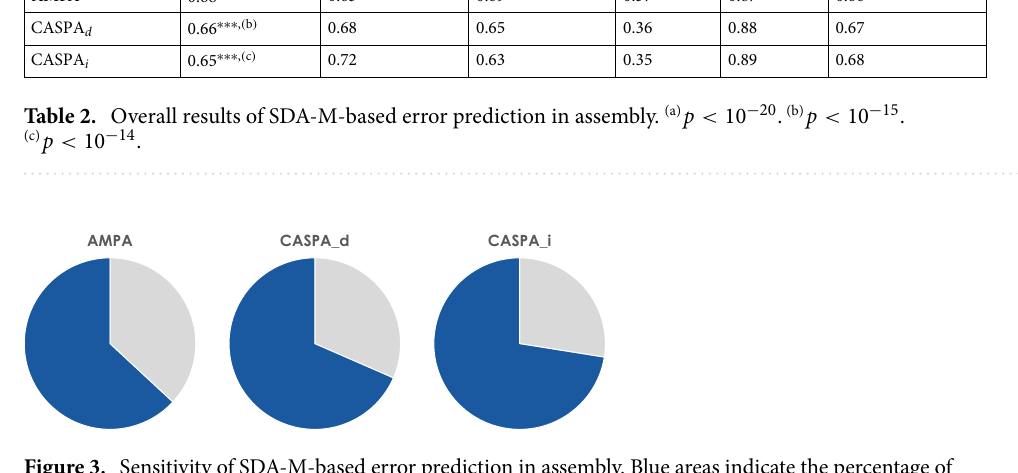
Table 3. Results of SDA-M-based error prediction for Lego Duplo assembly. (a) p < 10 − (c) p < 10 − 15 .